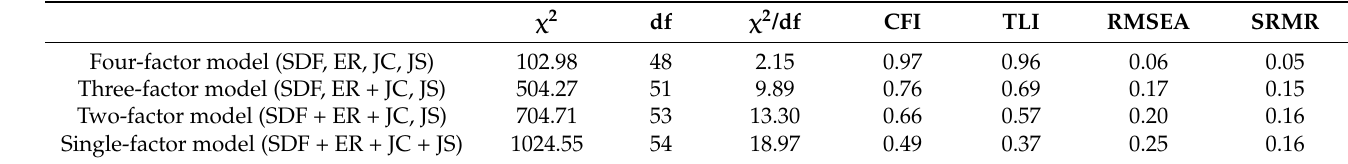
Table 2. Results of confirmatory factor analysis.